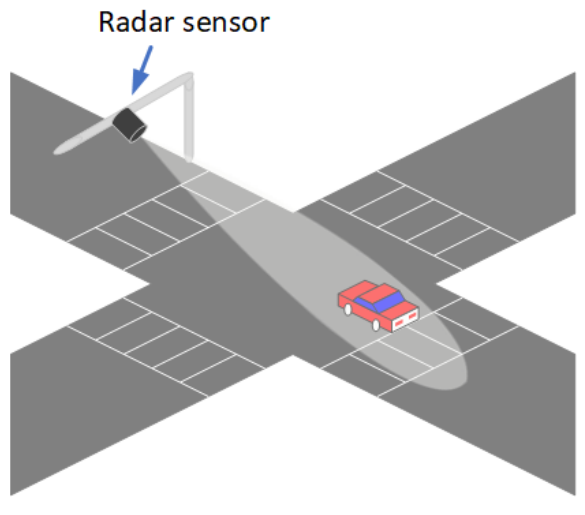
Figure 1. Traffic road scene.